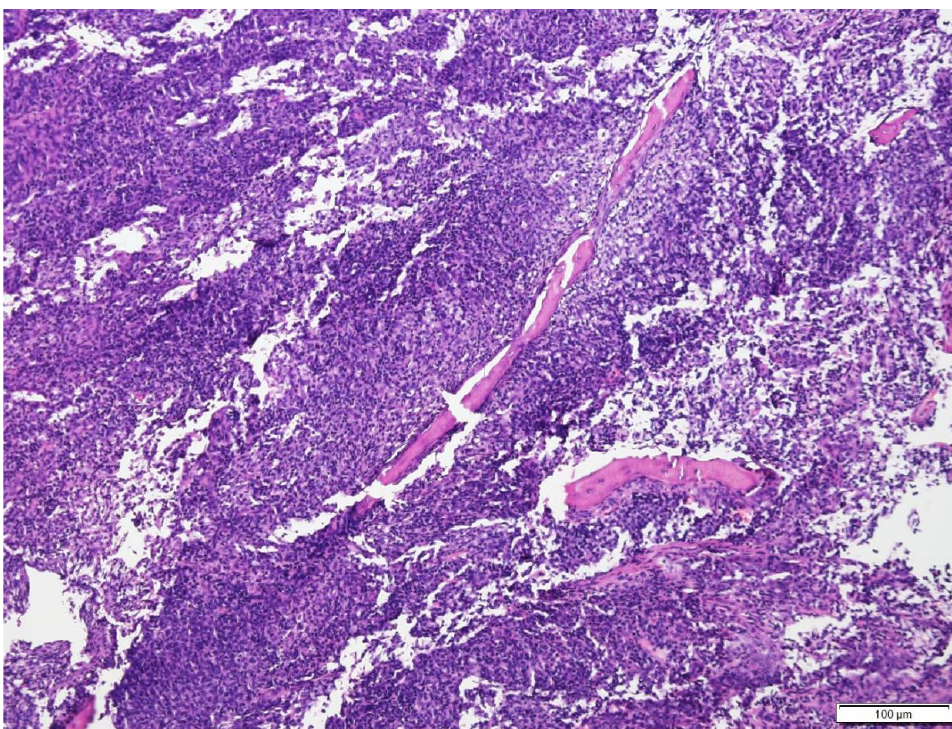
Figure 7. Histologic findings of nasal biopsy of Case N.3. The submucosa is expanded by dense sheets of neoplastic cells separating the turbinate bone spicules. H&E stain (100× magnification).